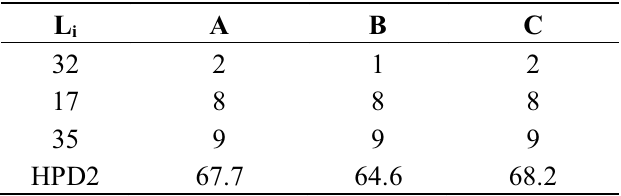
Table 3. Scenarios of species loss from coral ecosystems, based on the partial tree of has branch lengths, including a hypothetical branch of length 32 from Figure 6. Column L i another part of the tree. Columns A, B, and C correspond to 3 scenarios for number of ecosystems for each species/branch. The bottom row reports, for each scenario, the corresponding HPD2